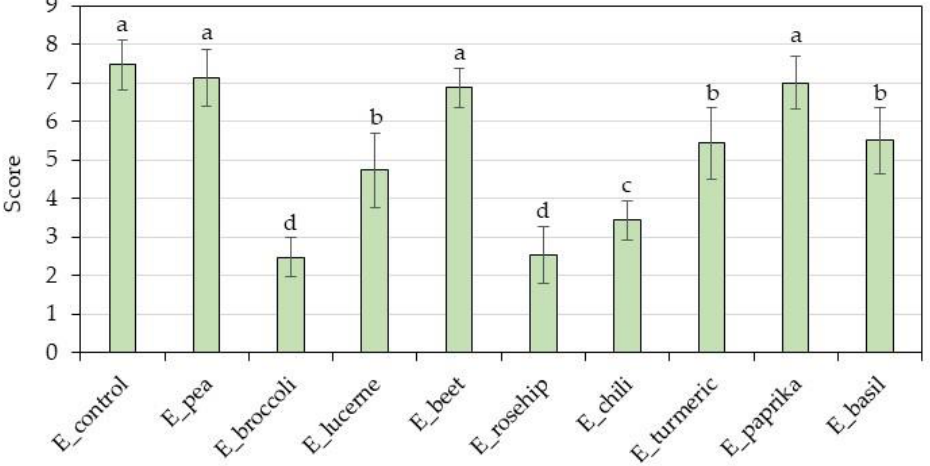
Figure 7. Overall acceptability of the extrudates. Each bar represents mean values ± standard deviations (n = 30). Different letters indicate significant differences between samples ( p <